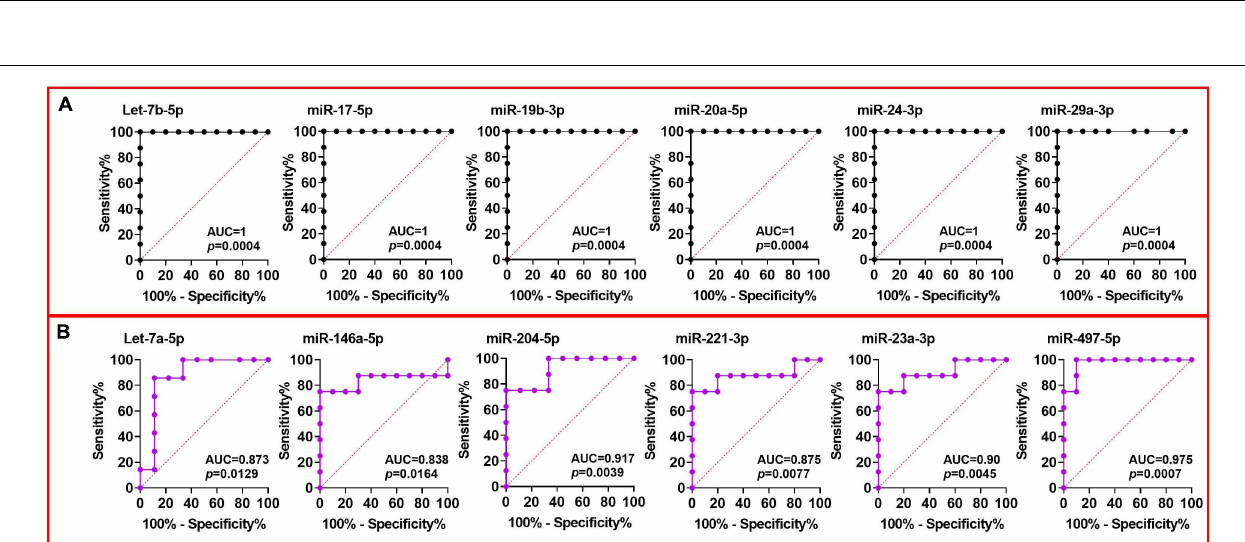
Frontiers in Molecular Biosciences |